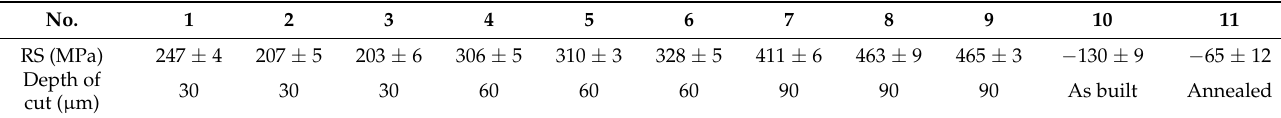
Table 2. XRD residual stress measurements for annealed and ground specimens with various depth of cut (RS; Resid- ual